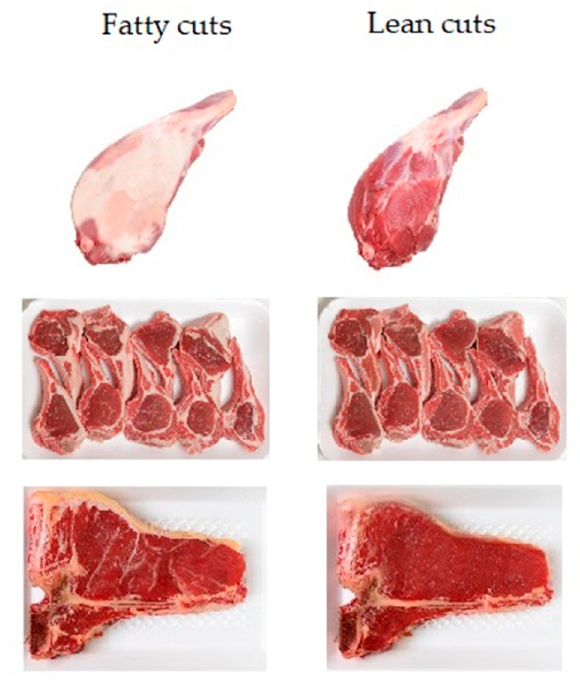
Figure 2. Examples of fat content presented in red meat cuts.